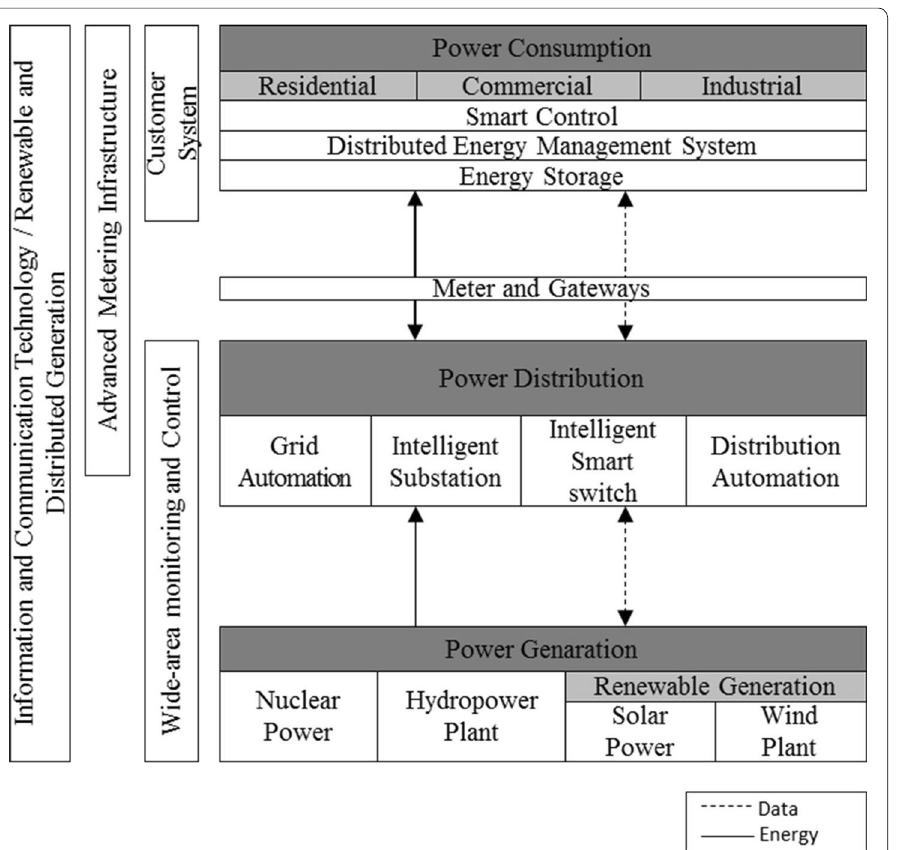
Fig. 1 Smart grid value chain. Bidirectional flow of energy and data between power generation, distribution and